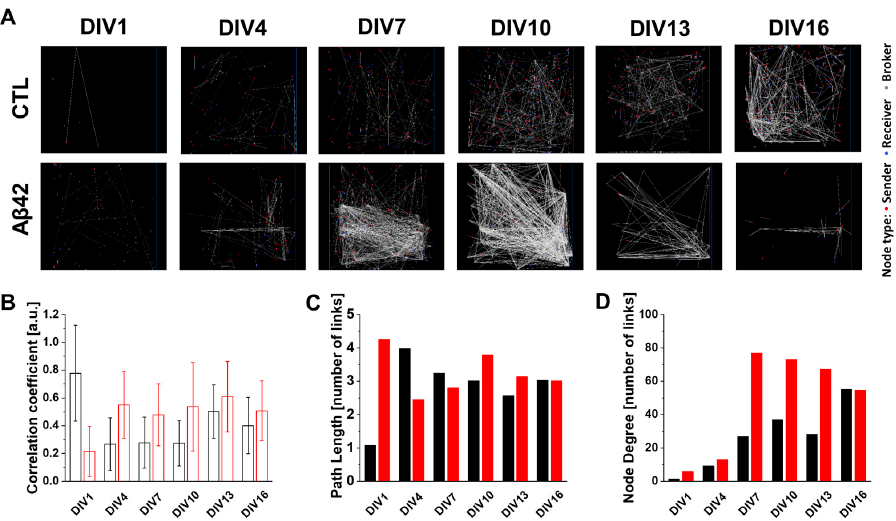
Figure 2. Neuronal connectivity map and its characterization based on graph theory. ( A ) Neuronal connectivity map in spontaneous neuronal activation during 5 min recordings. Control (CTL) and A β 42 oligomer treatment groups in DIV1, 4, 7, 10, 13, and 16. The red dot represents a node of the sender, blue for the receiver, and gray for the broker. The white line describes the connection between nodes. ( B ) Average of clustering coefficients from neuronal connections for 5 min recordings for control (black) and A β 42 (red) cultures during DIVs. The line represents a standard deviation. ( C ) Histogram plot of average path length in a number of links. ( D ) Histogram plot of node degrees in a number of links.